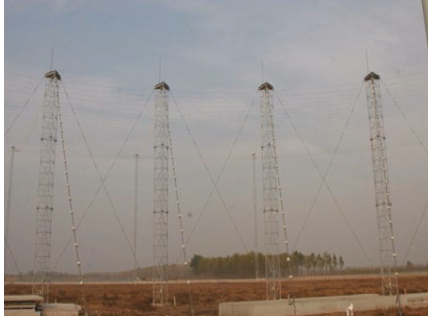
Figure 9: The fabricated direction fi nding array by using the proposed nonlinear